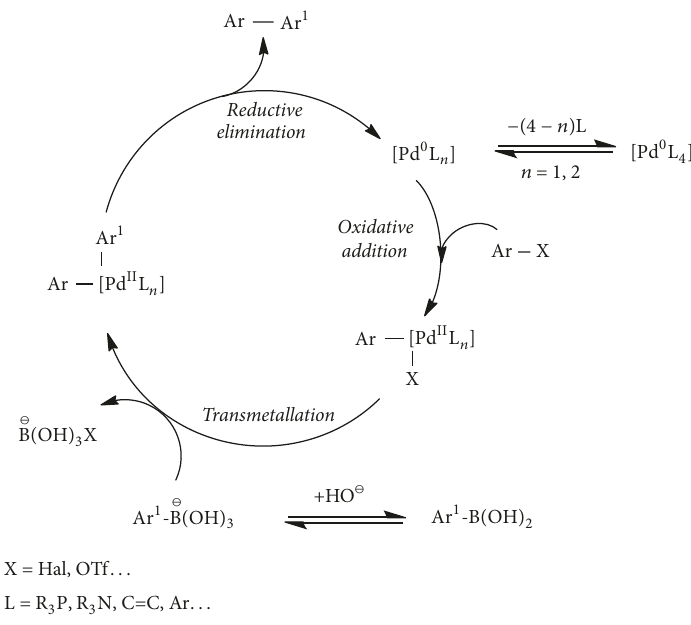
Scheme 1: Generally accepted mechanism of SM